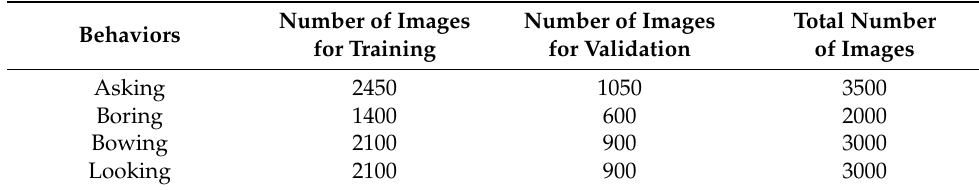
Table 1. Description of the training